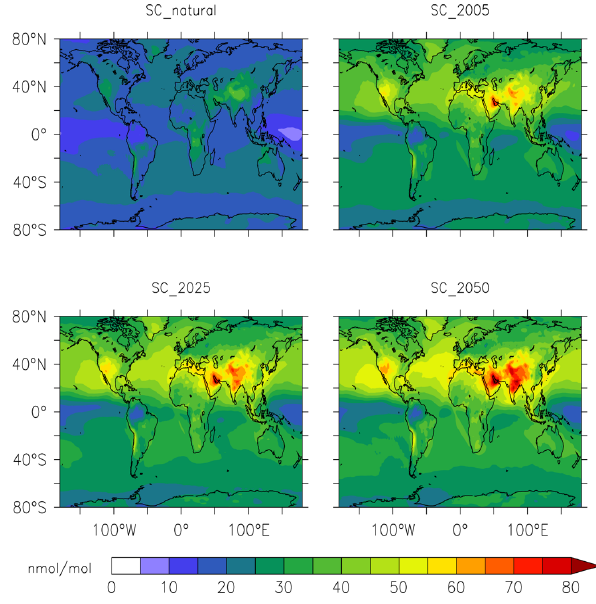
Fig. 3. Model calculated annual mean near-surface sulphur dioxide in nmol mol − 1 from simulation SC natural , SC 2005 , SC 2025 and SC 2050 .